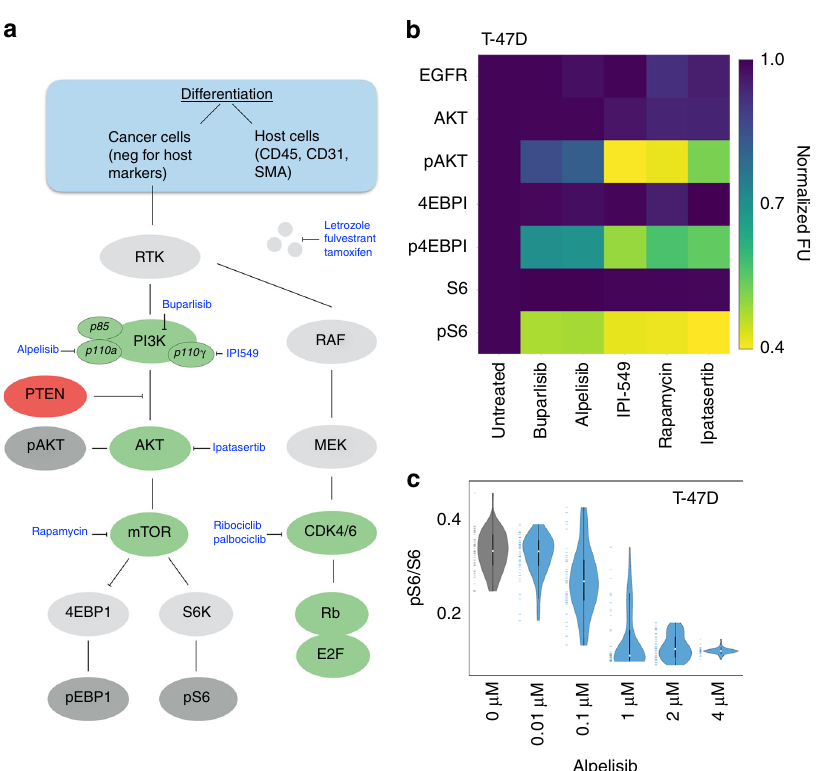
Fig. 5 Pathway analysis and therapeutic intervention. a Clinical sample analysis. Harvested cells are fi rst differentiated into host and cancer cells and subsequent analyses are performed on the latter. Primary drug targets are shown in green. b Image analysis of ~500 T47D cells before/after exposure to targeted therapeutics showing initial response normalized to 1 and their measured, corrected fl uorescence response according to the described scale bar. c Dose – response analysis of alpelisib (BYL-719), a selective PI3K inhibitor of p110 α . The violin plots show sample heterogeneity to response and are consistent with an IC50 of <1 μ M in the T47D cell